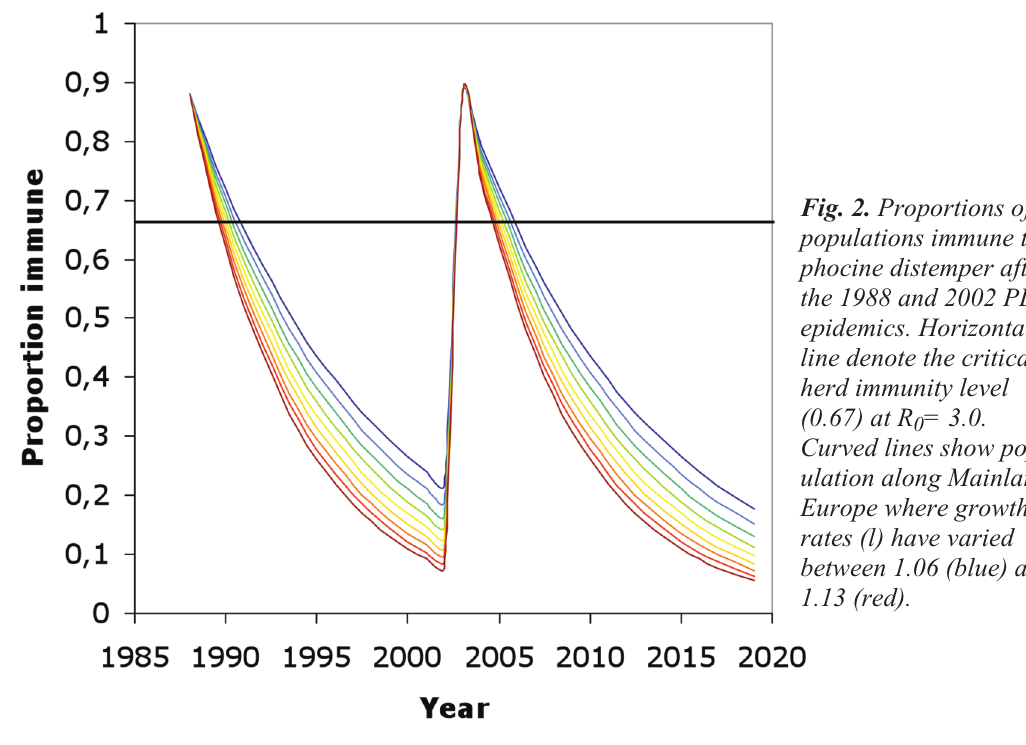
Fig. 2. Proportions of populations immune to phocine distemper after the 1988 and 2002 PDV epidemics. Horizontal line denote the critical herd immunity level (0.67) at R 0 = 3.0. Curved lines show pop- ulation along Mainland Europe where growth rates (l) have varied between 1.06 (blue) and 1.13